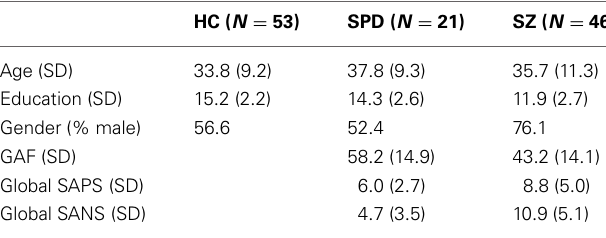
Table 1 | Demographics and visual contrast